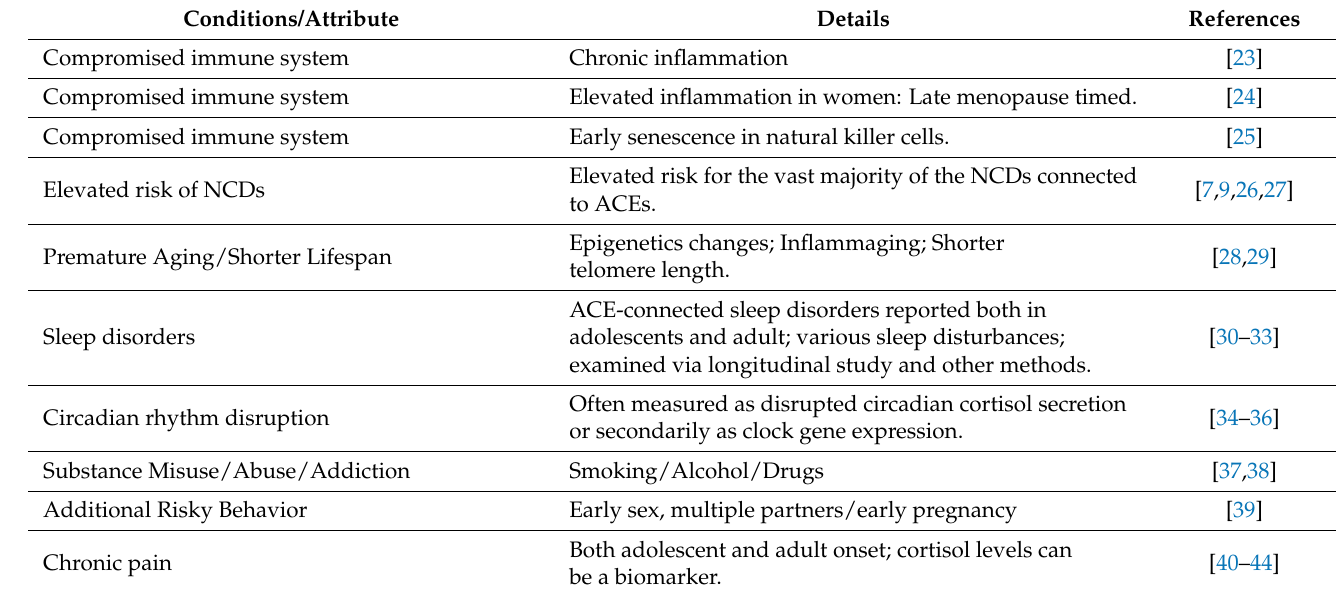
Table 1. Examples of Childhood and Adult Outcomes Linked with Adverse Childhood Experiences.